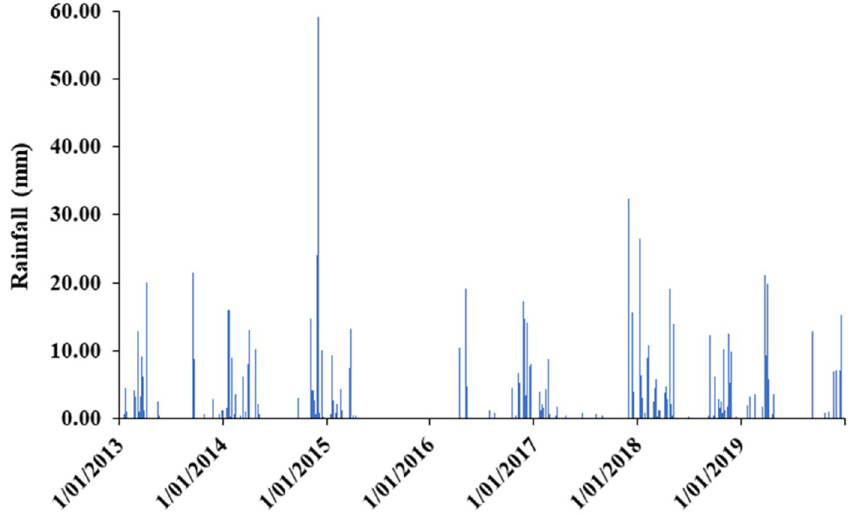
Figure 3. The evolution of rainfall over 7 years’ time horizon (2013–2019).